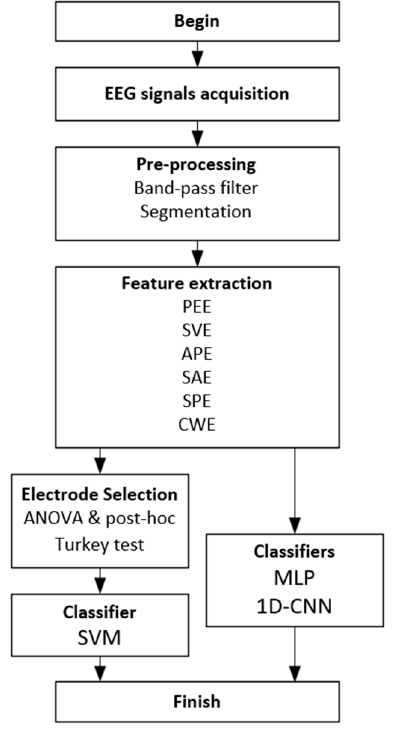
Figure 6. Workflow diagram of the proposed system.